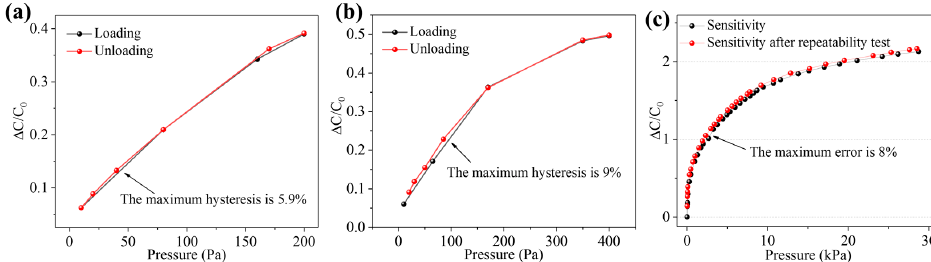
Figure 10. Sensor hysteresis and the sensitivity curve after repeatability test. ( a ) The hysteresis of the sensor under a dynamic pressure of 200 Pa. ( b ) The hysteresis of the sensor under a dynamic pressure of 400 Pa. ( c ) The sensitivity change of the sensor after a long-term repeated loading–unloading process. Table 1. Performance comparison between the proposed sensor and other sensors reported in the literature. The performance of the proposed sensor is compared with that of some reported sen- Sensor Structure